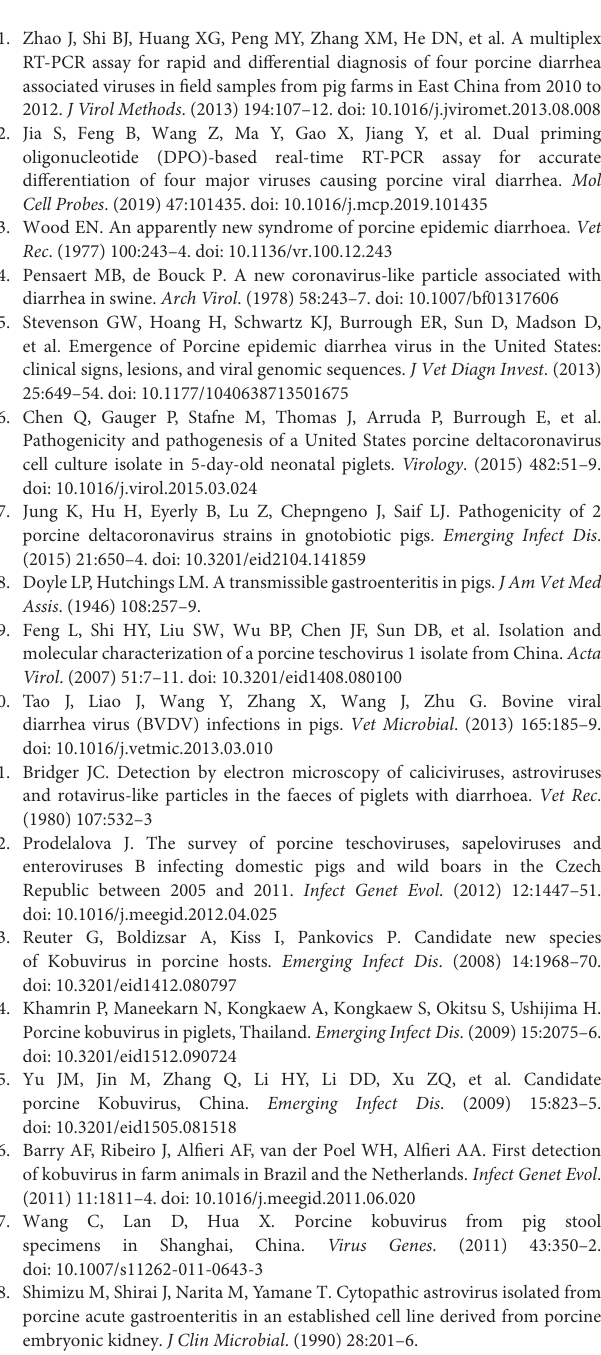
negative control; 21: PoRV;22: negative control. (B) The detection of singular Luminex xTAG reaction. Each column contains a negative control. Supplementary Figure 2 | The comparison of the sensitivity between the Luminex xTAG detection method and traditional RT-PCR method. The standard plasmids were 10-fold multiplicationally diluted to be detected as the templates. (A) The sensitivity of traditional RT-PCR method for seven kinds of diarrhea